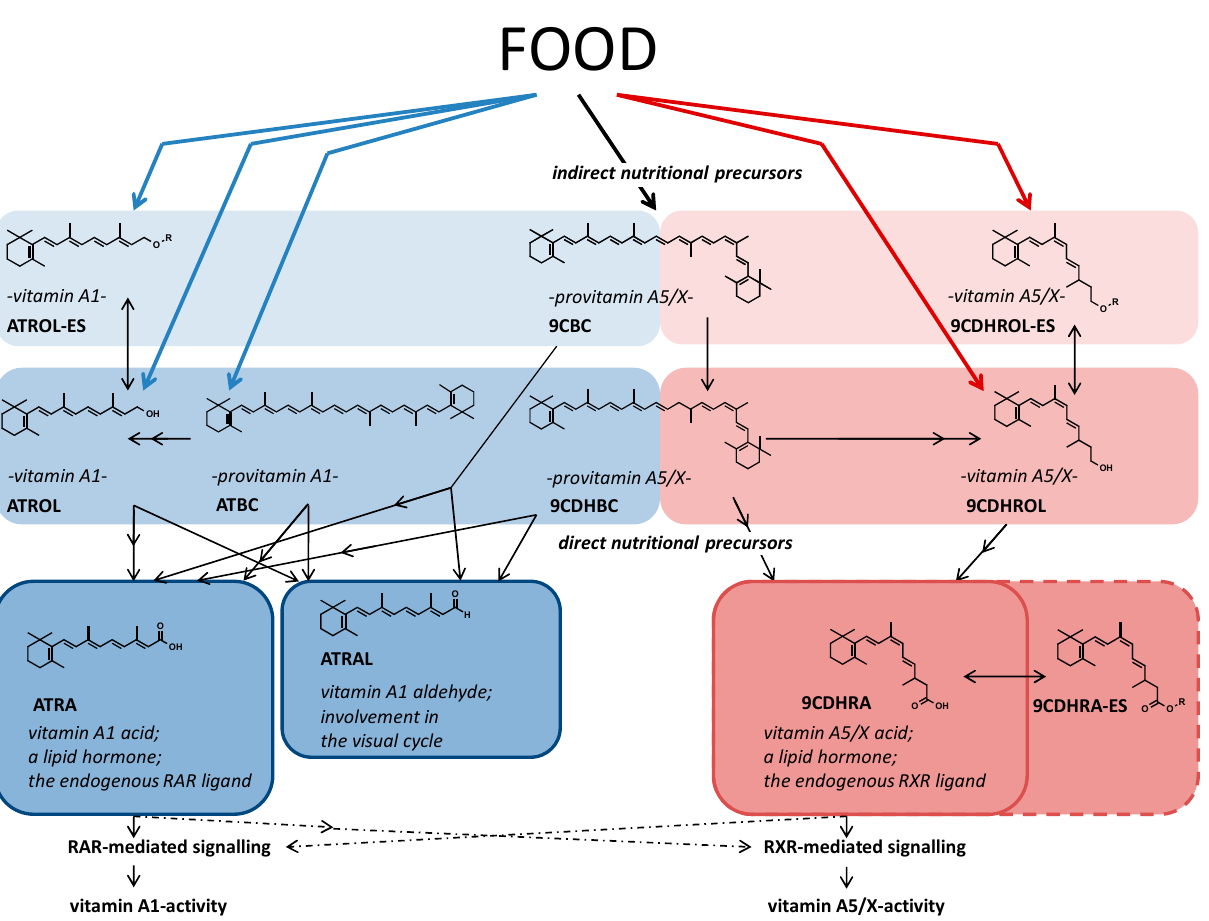
Figure 5. Metabolic pathway of the novel vitamin A5/X / provitamin A5/X pathway. Simplified metabolic pathway including structural formula starting from nutritionally derived carotenoids and retinoids and key metabolites of the vitamin A1 cluster pathway on the left side and colored in blue background: all- trans -retinyl ester (ATROL-ES), all- trans - retinol (ATROL), all- trans - β , β -carotene (ATBC), 9- cis - β , β -carotene (9CBC) to all- trans -retinal (ATRAL) and all- trans -retinoic acid (ATRA) as the bioactive metabolites of the vitamin A1 cluster pathway. On the right side, and colored in reddish background, the novel claimed vitamin A5/X cluster pathway with 9CBC as a partial vitamin A1/A5/X derivative representing the indirect nutritional vitamin A5/X precursor, with